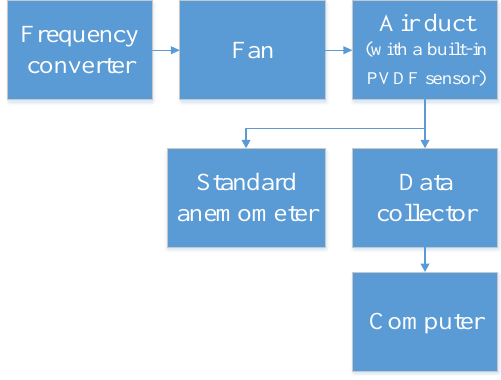
Figure 9. Instrument connection sequence. Sensors 2019 , 19